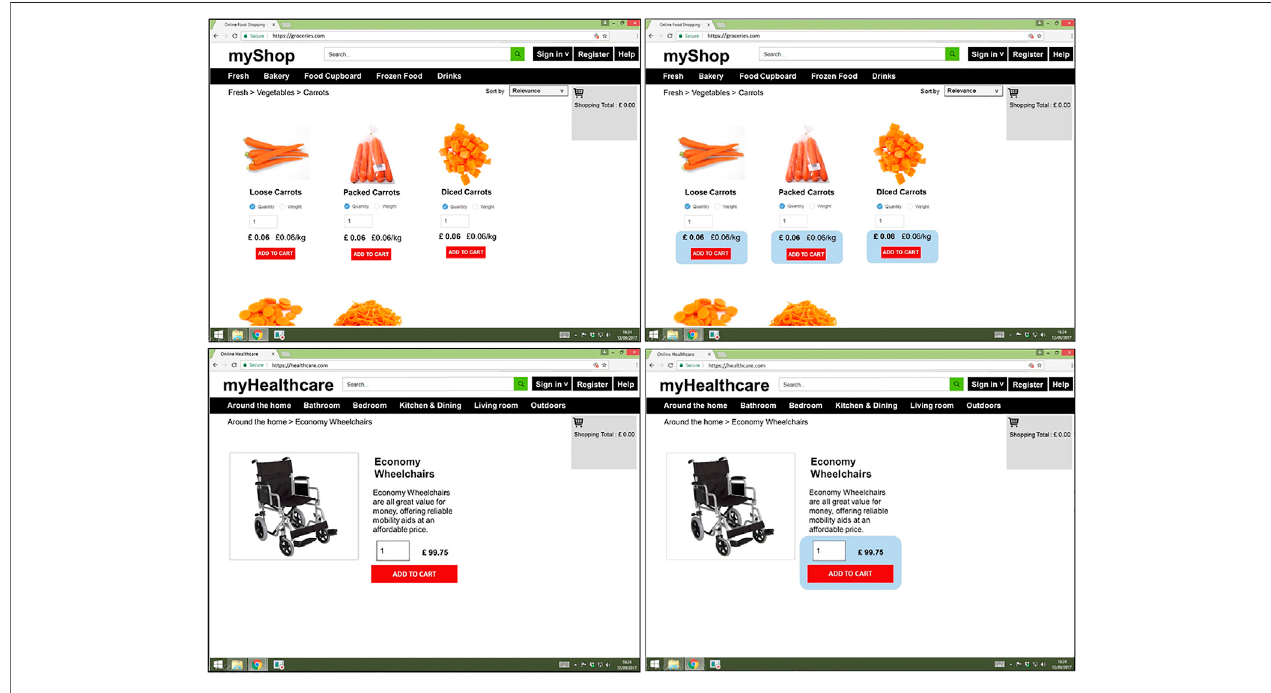
FIGURE 4 | Carrot and wheelchair pages with and without “ buy box ” designs.